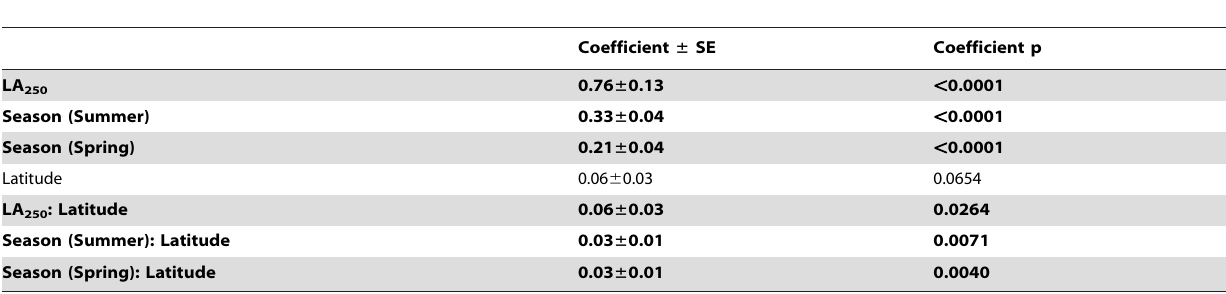
Table 5. Results from the most parsimonious mixed model: relating chl-a to integrated light attenuation in the top 250 m of the water column ( LA 250 ), latitude and season and their significant